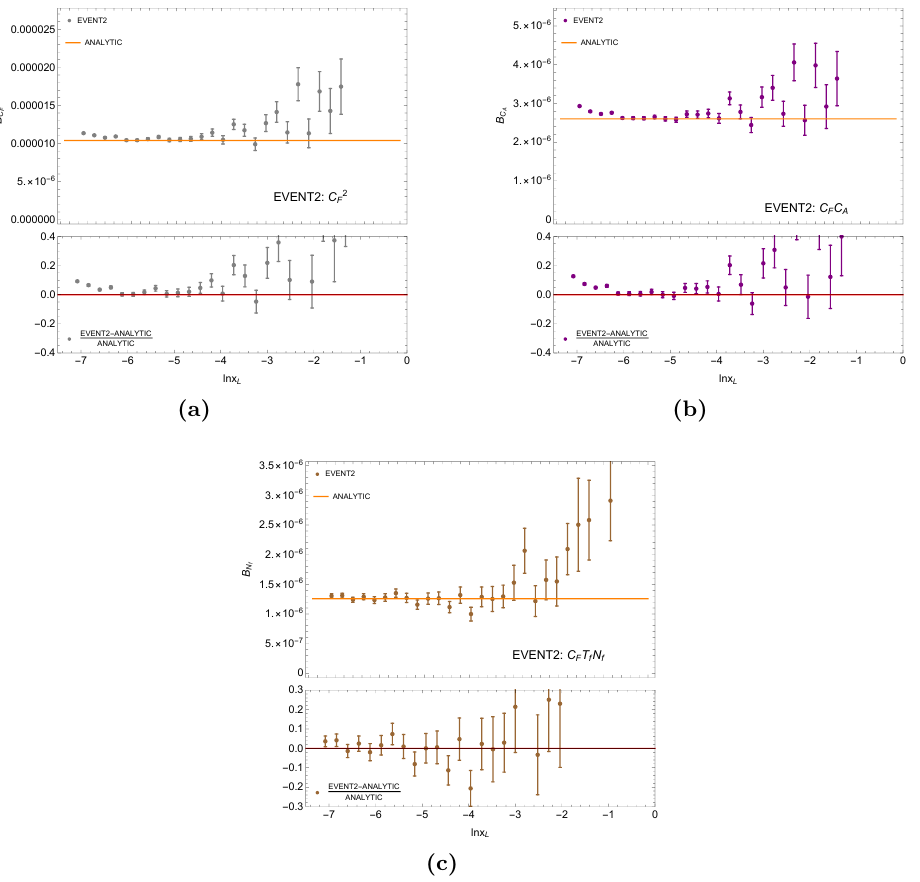
Figure 10. A comparison of the analytic results for the EEEC in an equilateral triangle con(cid:12)gura- tion with numerical results from EVENT2 , separated by color channel. Results are shown for the C 2 , C F C A and C F N f T f channels, following the decomposition given in the text. Good agreement F is observed for each